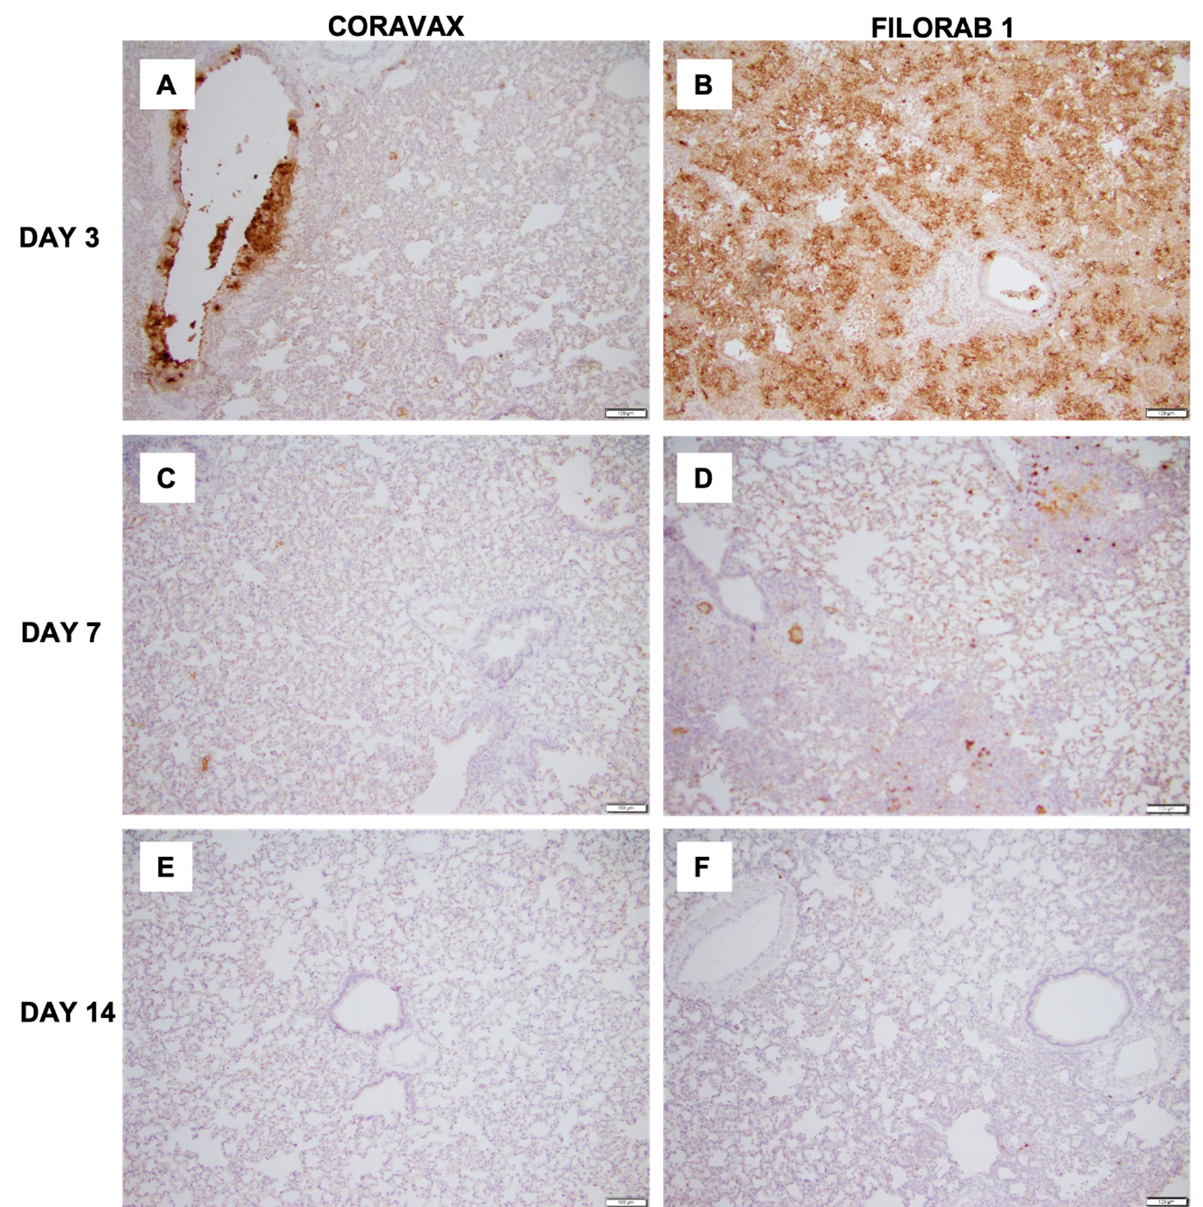
Figure 8. SARS-CoV-2 nucleoprotein antigen lung staining. Representative histological images of SARS-CoV-2 nucleoprotein (N) antigen staining in the lungs of control and vaccinated hamsters. ( A , C , E ) CORAVAX days 3, 7, and 14 p.c. (B,D,F) FILORAB1 days 3, 7, and 14 p.c. The presence of the SARS-CoV-2 N antigen is indicated by the brown DAB (3, 3 ′ -diaminobenzidine) stain in the lungs. A significantly higher amount of N antigen staining is observed in the FILORAB1 lungs ( B ) than in CORAVAX lungs ( A ) on day 3 p.c. On day 7 p.c., immunohistochemical stain for the SARS-CoV-2 nucleoprotein antigen shows scattered positive cells in the control group ( D ) and no definite positive cells in the vaccinated group ( C ). SARS-CoV-2 N antigen staining is absent in the FILORAB1 ( F ) and CORAVAX lungs ( E ) on day 14 p.c. All images were taken with 10 × objective and 0.5 camera adaptor; the scale bar in every image equals 100 µ